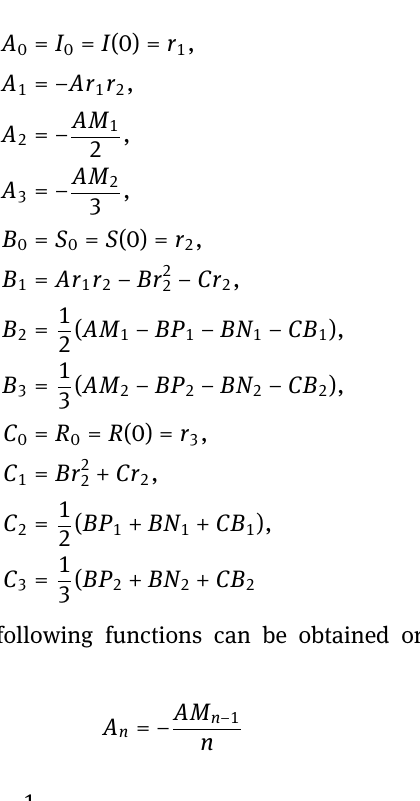
Fig. 2. Comparison of the LADM solutions of I(t) with numerical